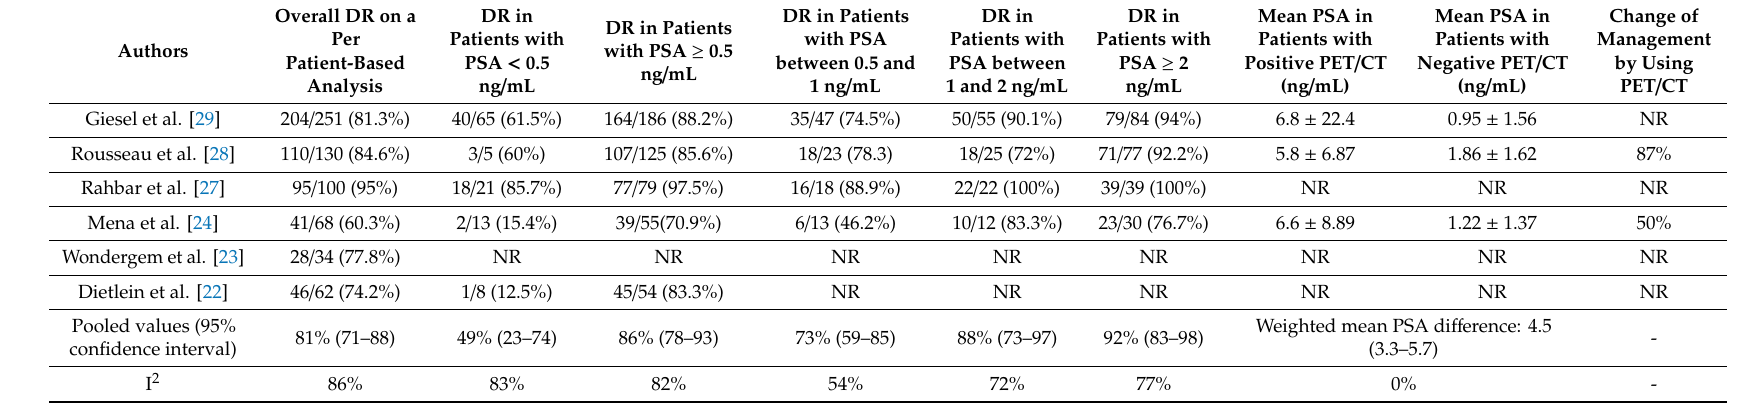
Table 3. Main findings of the included studies about 18 F-PSMA PET / CT in patients with biochemical recurrence of prostate